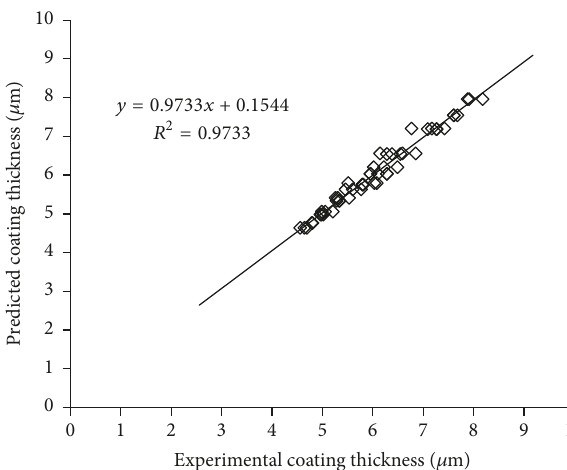
Figure 6: Comparison of predicted and experimental coating